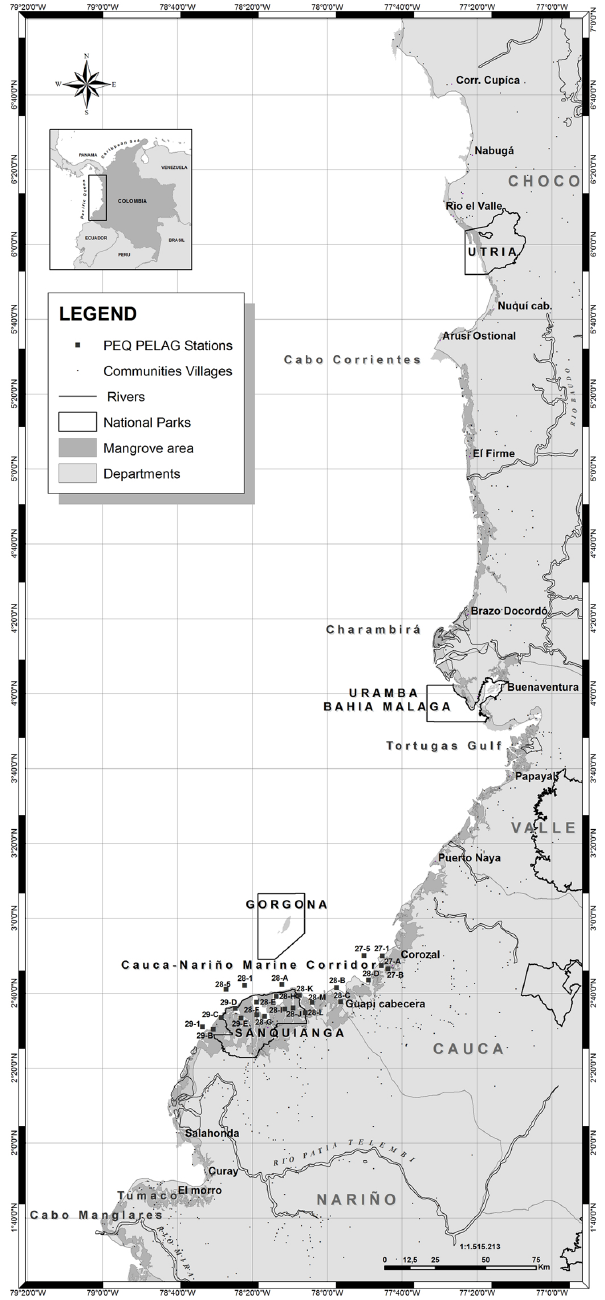
Fig. 1. Study area with two areas of the Colombian Pacific known to harbor large numbers of C. mysticetus : the Tortugas Gulf; and the Cauca-Nari˜no marine corridor; map includes a grid of 24 oceano- graphic and biologic sampling